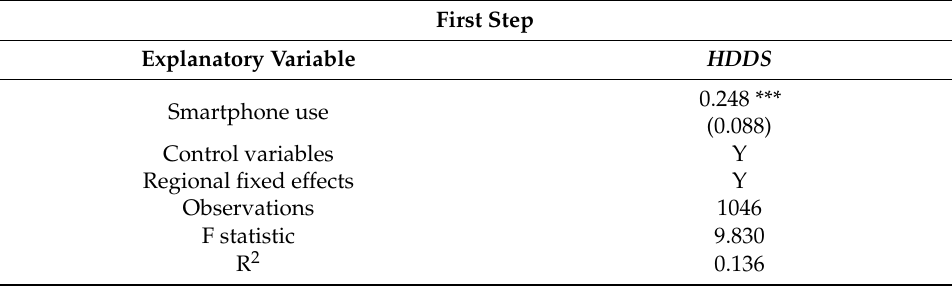
Table 6. Mechanism analysis: Step (1).